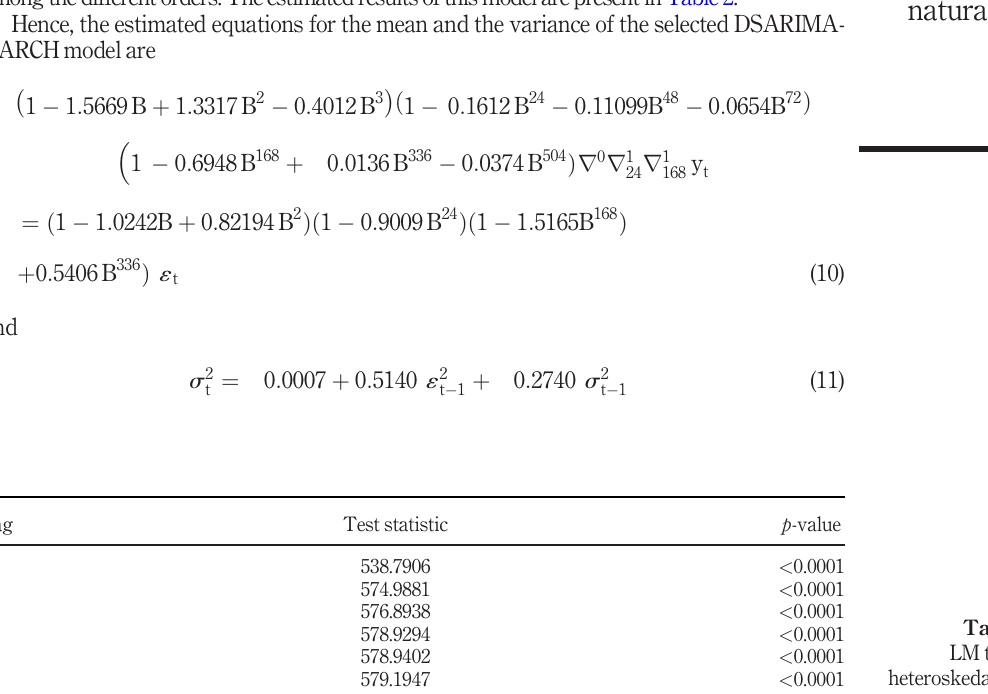
Table 1. LM test